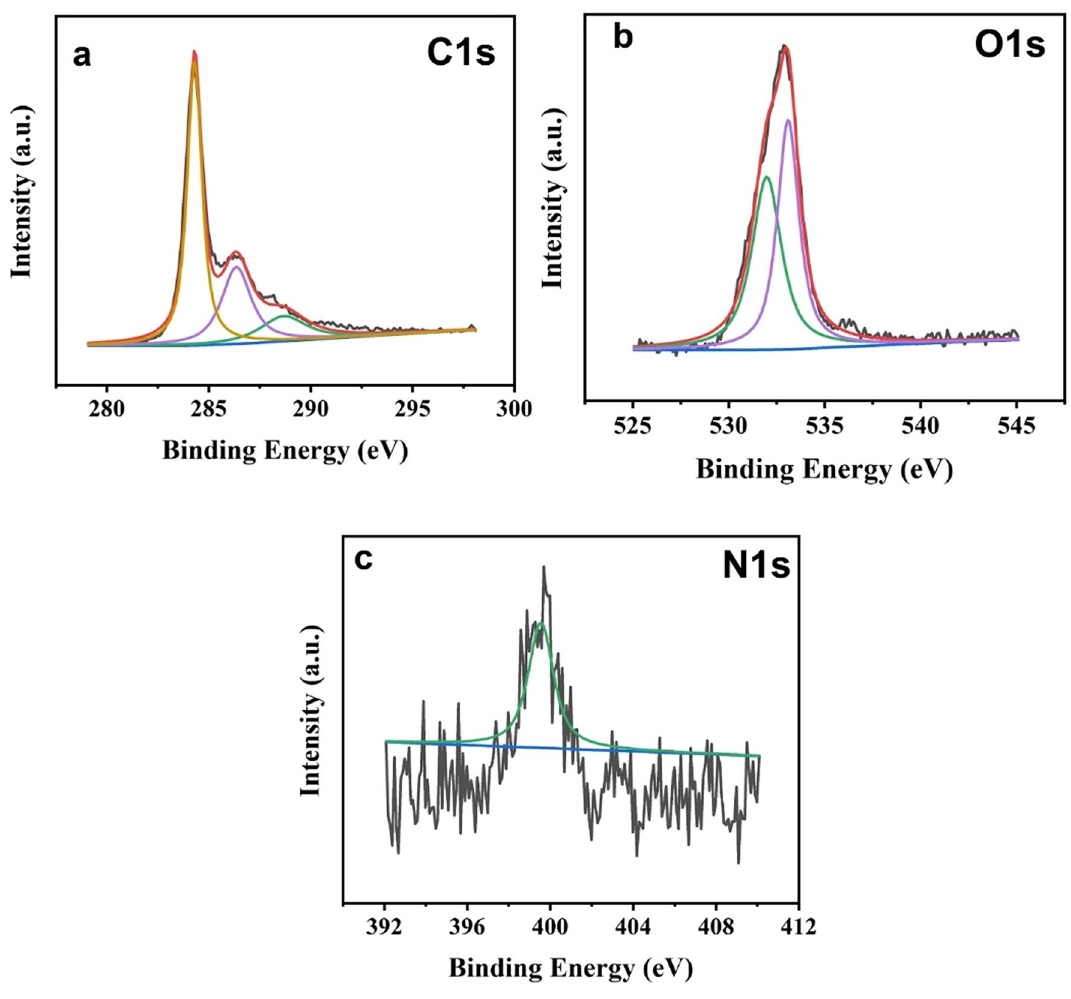
Figure 5. XPS results of the N-doped MWCNT/CMC